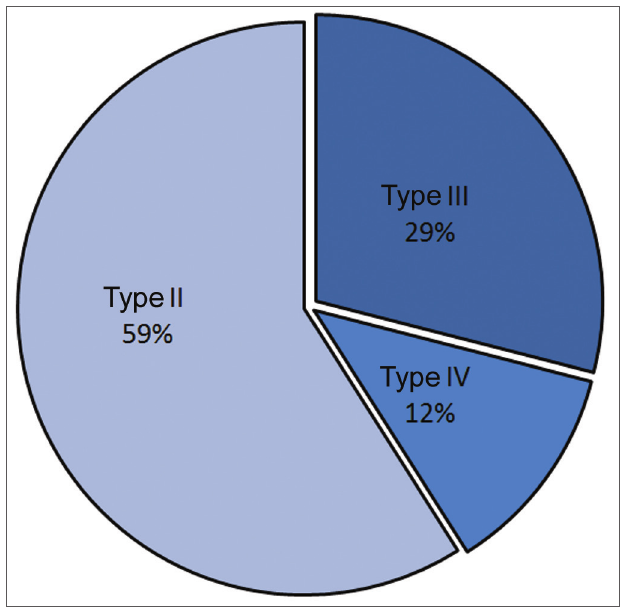
Graph 1. Type of posterior glottic stenosis in the series (Bogdasarian and Olson classification 8